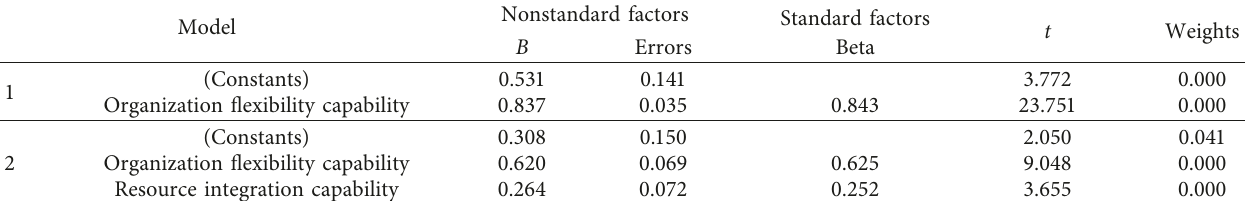
Table 7: Regression coefficient table of dynamic capability dimensions on innovation